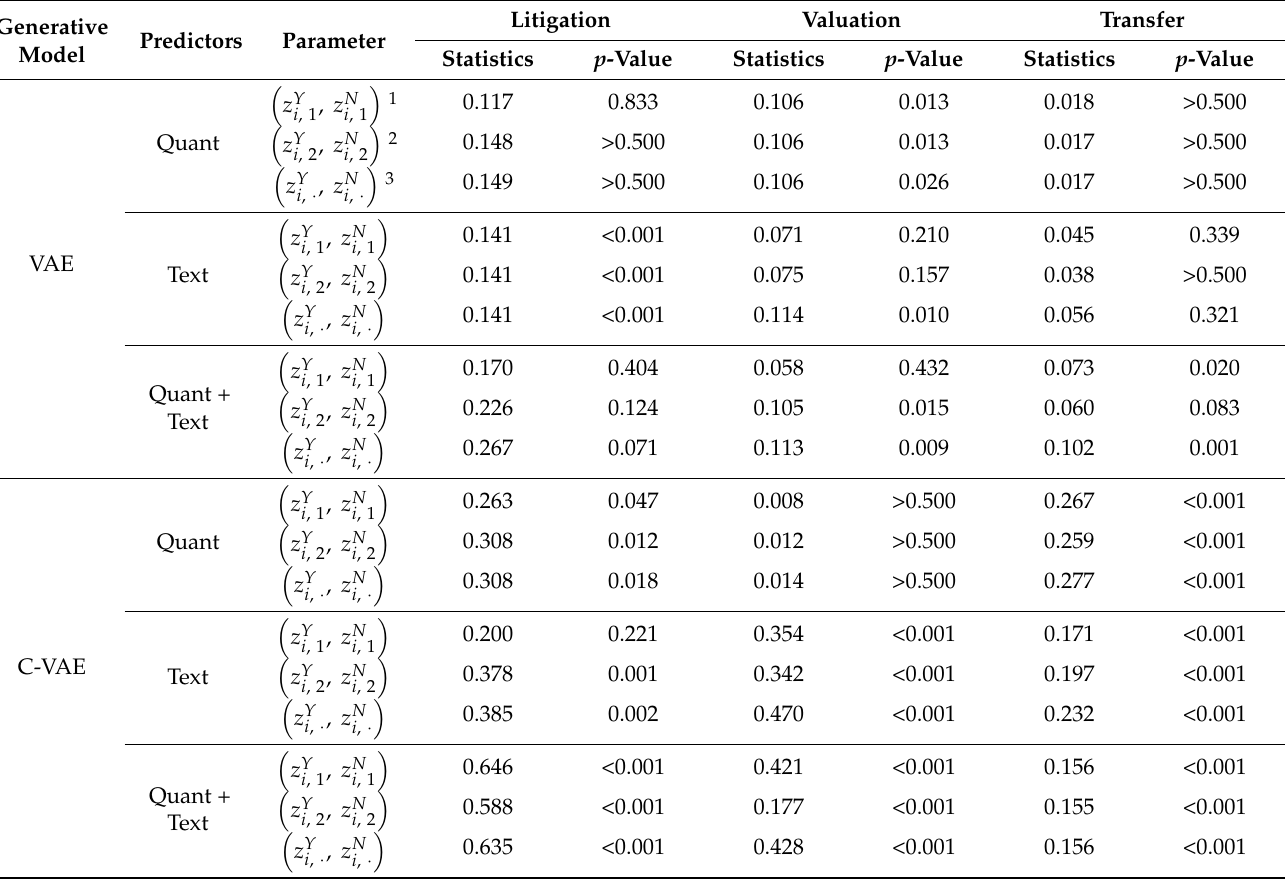
Table 4. Results of statistical tests for Hypothesis 2.